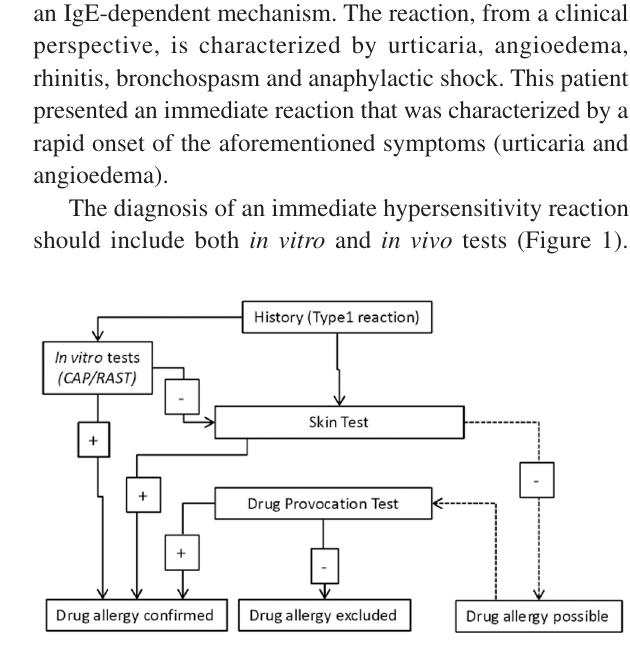
Figure 1 - Flow chart for the evaluation of type 1 hypersensitivity drug reactions. Legend: (+) positive; (-) negative or